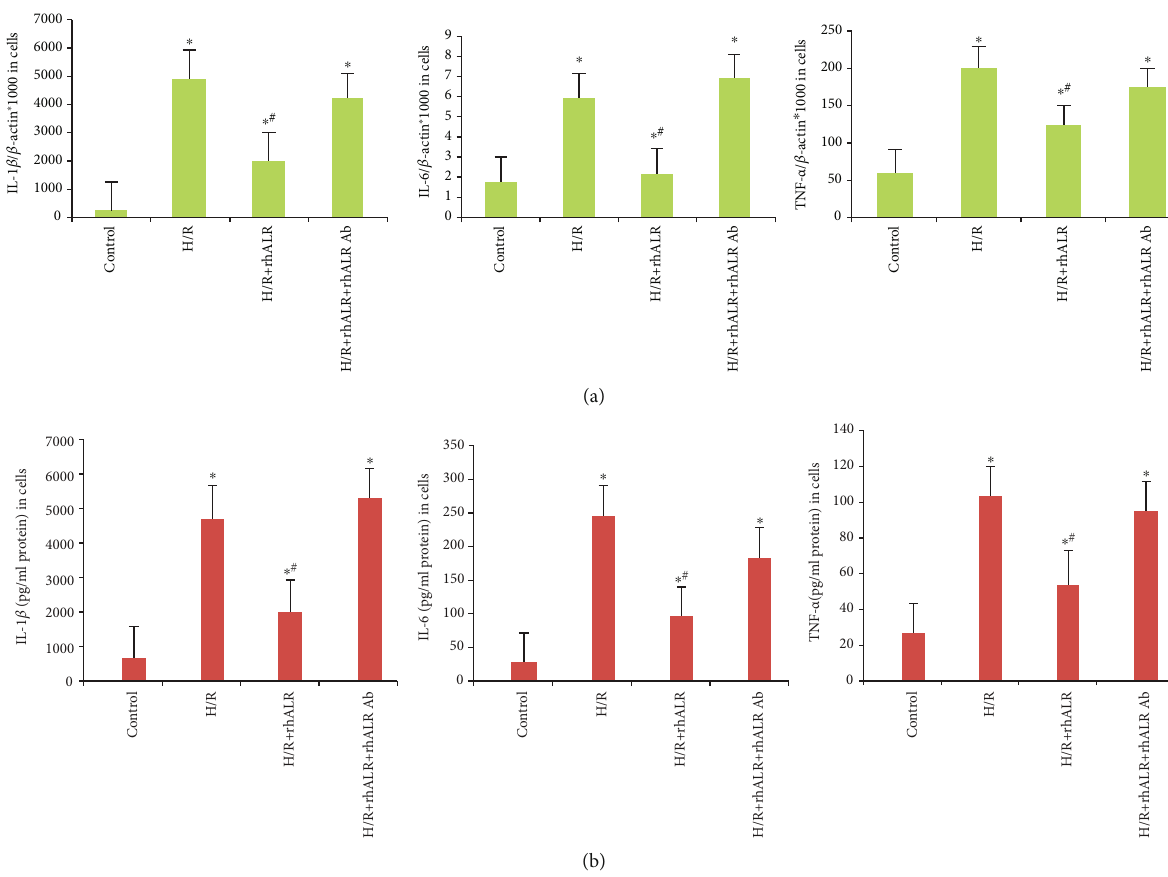
Figure 5: rhALR alleviates in fl ammation in H/R-induced HK2 cells. (a, b) Real-time PCR and ELISA analysis showed that the mRNA and protein expressions of IL-1 β , IL-6, and TNF- α were upregulated after H/R induced reoxygenation for 12h in HK2 cells. No above changes were observed in the H/R+rhALR group and the negative control group. And exogenous anti-rhALR Ab evidently blocked the anti- in fl ammatory e ff ect of rhALR. All data obtained were expressed as the mean ± SD . ∗ P < 0 : 05 vs. negative control, # P < 0 : 05 vs.